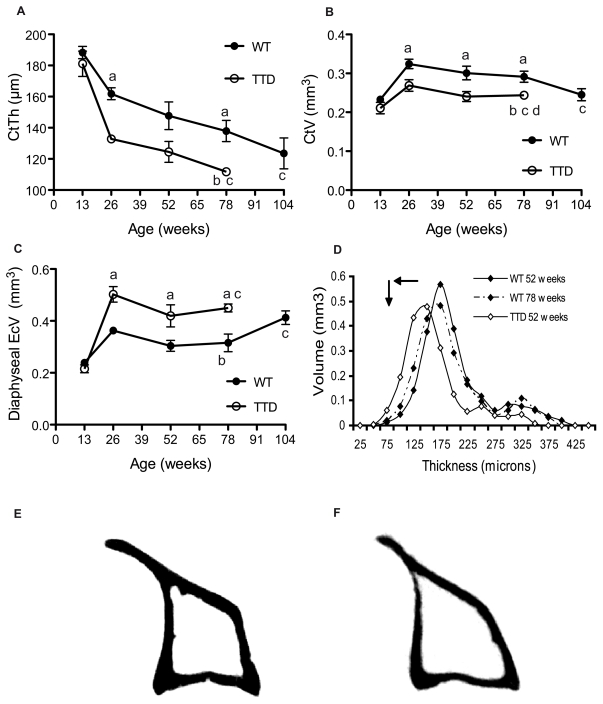
Age-related cortical bone loss in male TTD mice.Cortical bone parameters (A-D) were studied in aging wild type (solid) and TTD (open) tibial diaphyses.(A) Cortical thickness (Ct.Th.), (B) cortical volume (Ct.V.), (C) endocortical volume (Ec.V.), (D) 3D thickness distribution. Figures E and F depict the significant decrease in cortical thickness when comparing 26 week old wild type (E) and TTD (F) mice. Statistics: a= student t-test; p<0.05 wild type vs. TTD, b−d = 2 way ANOVA; p<0.05. b= significant difference between wild type and TTD with aging, c= signifcant difference with aging within a genotype, d= a significant interaction between age and genotype. Error bars represent SEM.